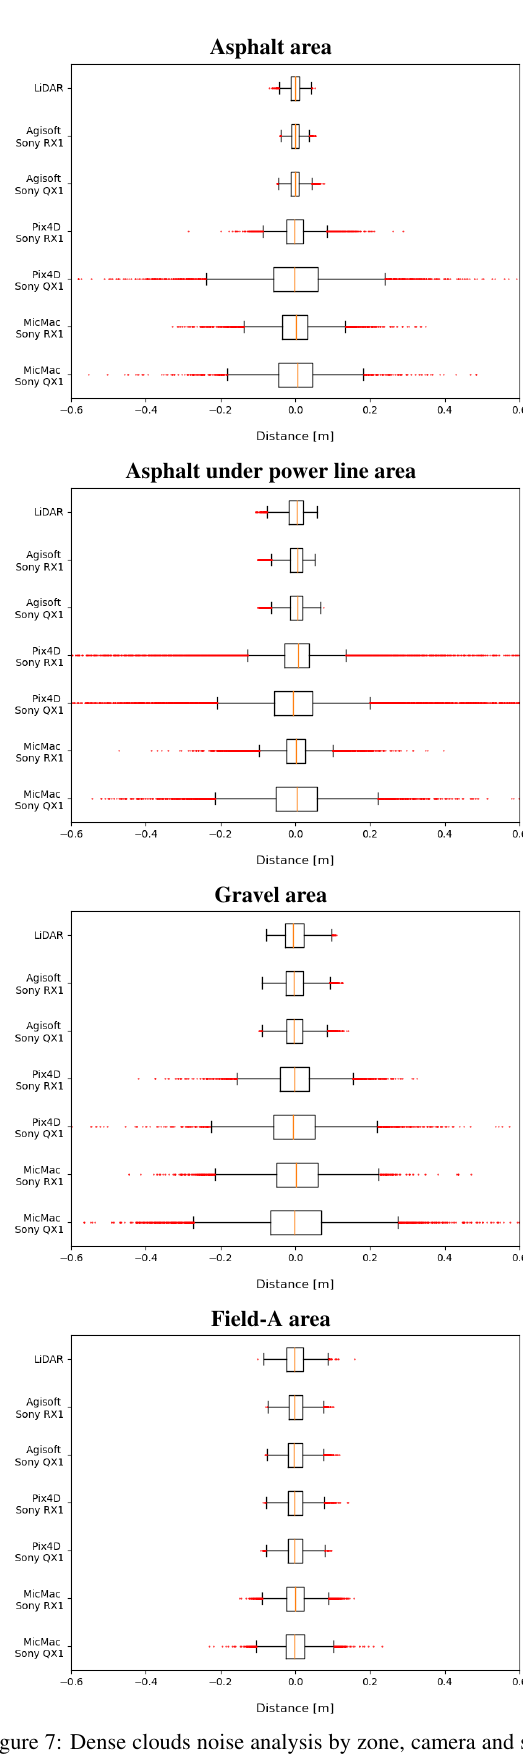
Figure 7: Dense clouds noise analysis by zone, camera and soft- ware -